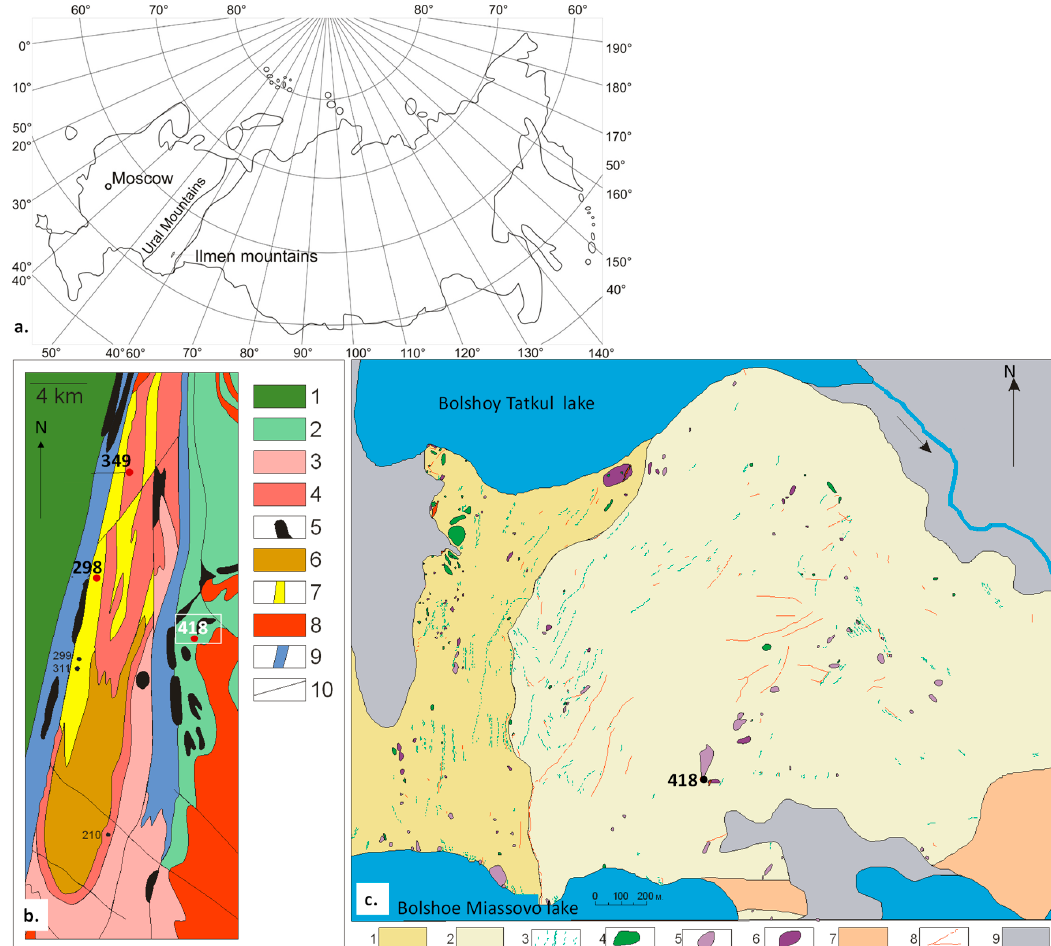
Figure 1. Location and geology of Ilmen sapphire deposits in meta-ultramafic host rocks: ( a ) General map of Russia showing location of Ilmen Mountains within Urals; ( b ) Regional geologic map of Ilmenogorsky complex after [4] with location of corundum mines within syenite pegmatites (mines 298 and 349) and within meta-ultramafic host rocks (mine 418): 1—sedimentary-volcanogenic metamorphosed rocks of the East Urals mega-zone (Upper Devonian-Lower